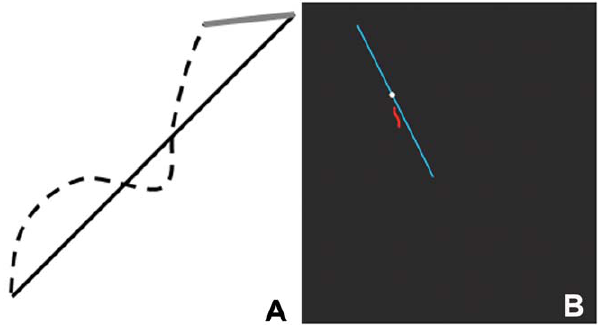
Figure 2. A schematic of the two dependent measures of performance. Solid line represents the target line that the subjects must trace. Dashed line represents a hypothetical path of the subject. Finish offset error (FO) is the hypotenuse of the right triangle that is formed from the end of the subject’s path and the end of the target line. Absolute deviation (AbDv) is the area between the subject’s path and the target line.